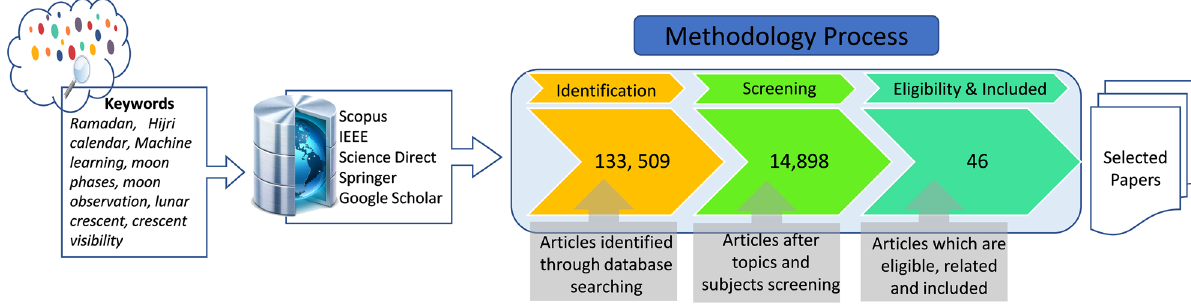
Figure 5. Literature review searching